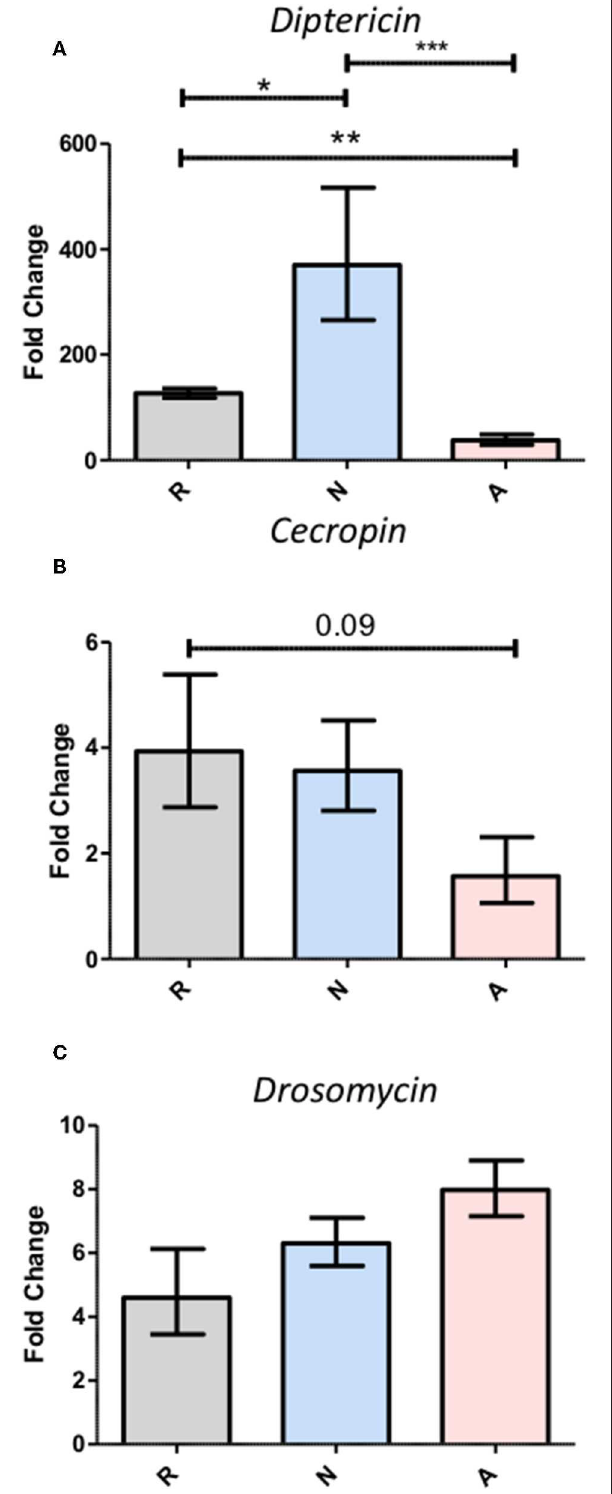
FIGURE 5 | Triple-concentration of the Heterorhabditis bacteriophora nematode Excreted/Secreted (ES) products exacerbates Diptericin